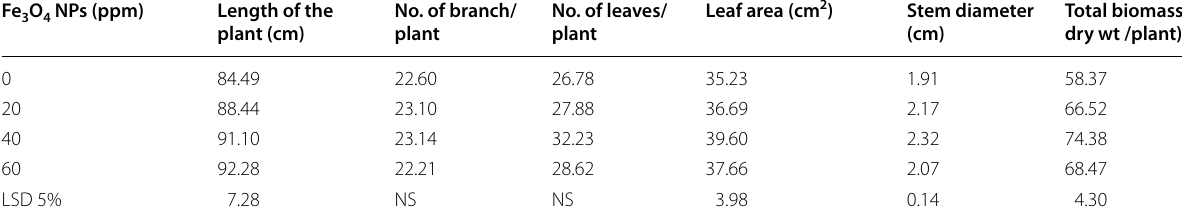
Table 3 Effect of Fe Fe 3 O 4 NPs (ppm)